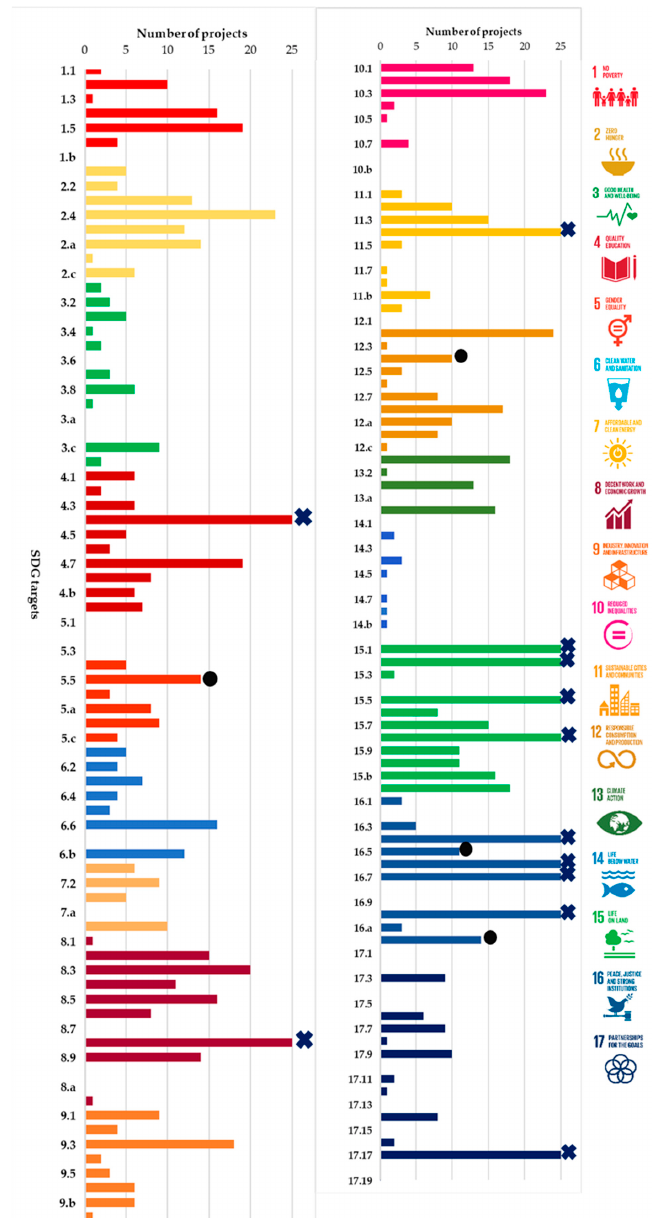
Figure 3. Numbers of REDD+ projects (out of 25) that have sustainability objectives similar to those listed as SDG targets. X = targets corresponding to requirements of both CCB Standards ( N = 25); O = targets corresponding to the requirements of the Third Edition only. Gold Level Criteria not highlighted here; see Supplementary Material. All 169 targets of Goals 1-17 are shown, with or without labels.